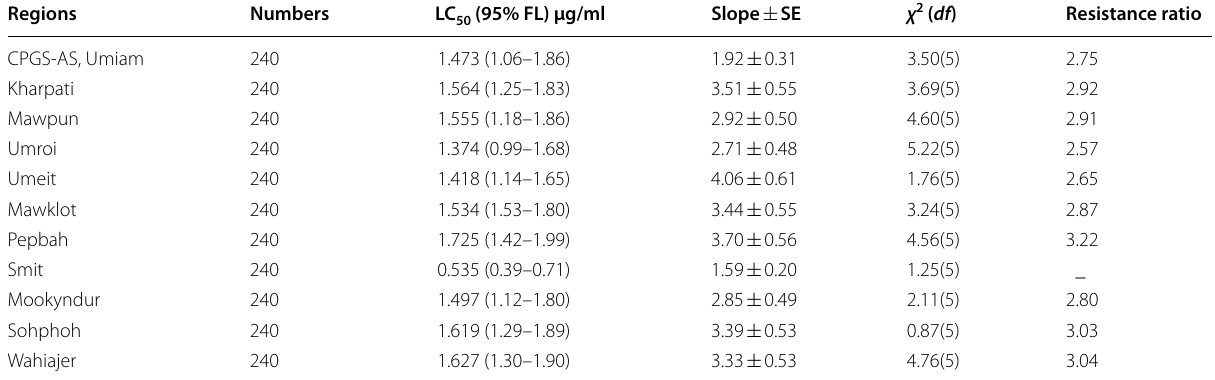
Table 3 Susceptibility of larvae of cabbage butterfly, Pieris brassicae from different locations to Bt Cry2Ab toxin